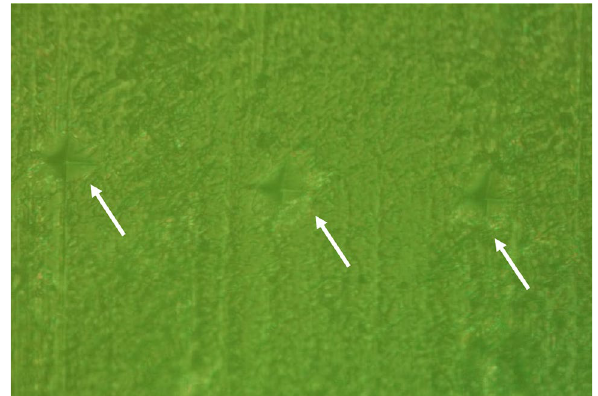
Figure 1. Microscopic image from a microhardness optical microscope (× 40) showing the power of microindentations at three different points (50, 100, and 150 µm) from the external enamel surface (white